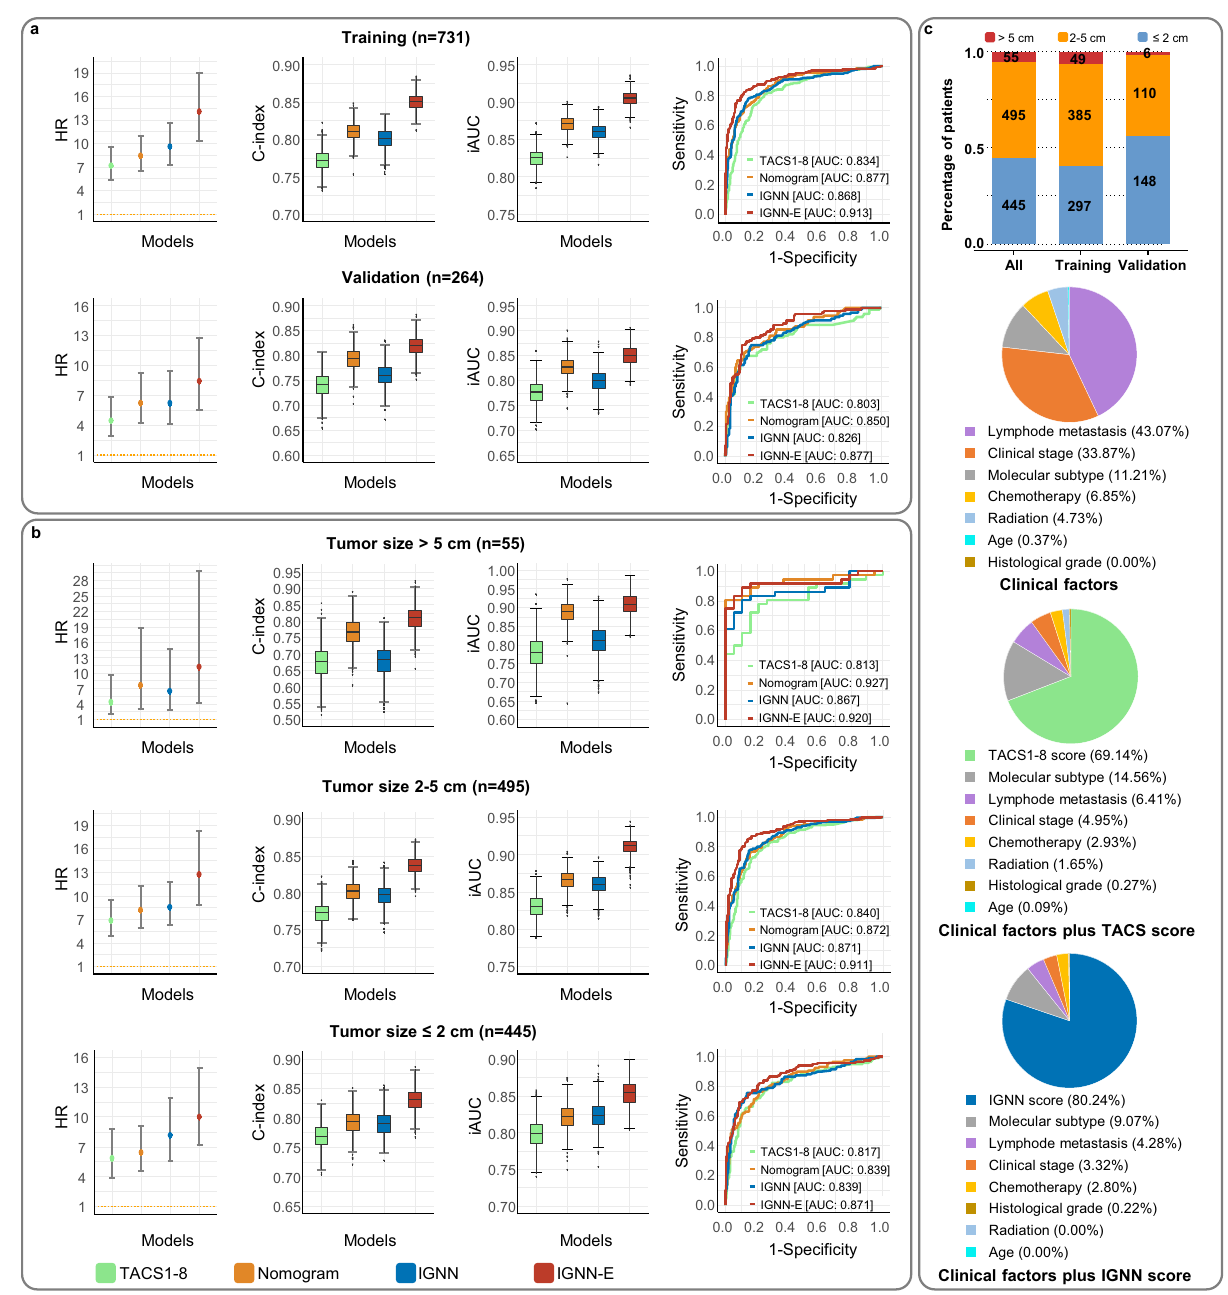
Fig. 2 Performance of four prognostic models in external validation. a , b HR from multivariate Cox proportional hazards regression analysis (in error bars, circles and upper/lower boundaries indicate mean value and 95% CIs, respectively. A two-sided log-rank test was performed to determine signi fi cance), distributions of C-index and iAUC from time-dependent AUC analysis (in boxplots, middle line represents the median value, the upper and lower boundaries of boxes indicate 25th and 75th percentile, the whiskers re fl ect 1.5 times of interquartile range, the upper and lower tails indicate the maxima and minima, and single points indicate the outliers. A two-sided unpaired t-test was performed to determine signi fi cance), and receiver operating characteristic (ROC) curves with AUC, for different groups of patients. c Tumor size distribution for patient cohorts (upper panel) and relative contributions of prognostic biomarkers in predicting DFS of 445 patients with a < 2 cm tumor from multivariate Cox proportional hazard regression analysis (lower panels). Chi-squared test was performed to determine signi fi cance. HR hazard ratio, C-index concordance index, AUC associated area under receiver operating characteristic curves, iAUC integrated cumulative/dynamic AUC, TACS (TACS1-8) tumor-associated collagen signatures, Nomogram, extended model of multivariate Cox proportional hazard regression, IGNN intratumor graph neural network, IGNN-E extended IGNN model with clinical information. Source data are provided as a Source Data fi